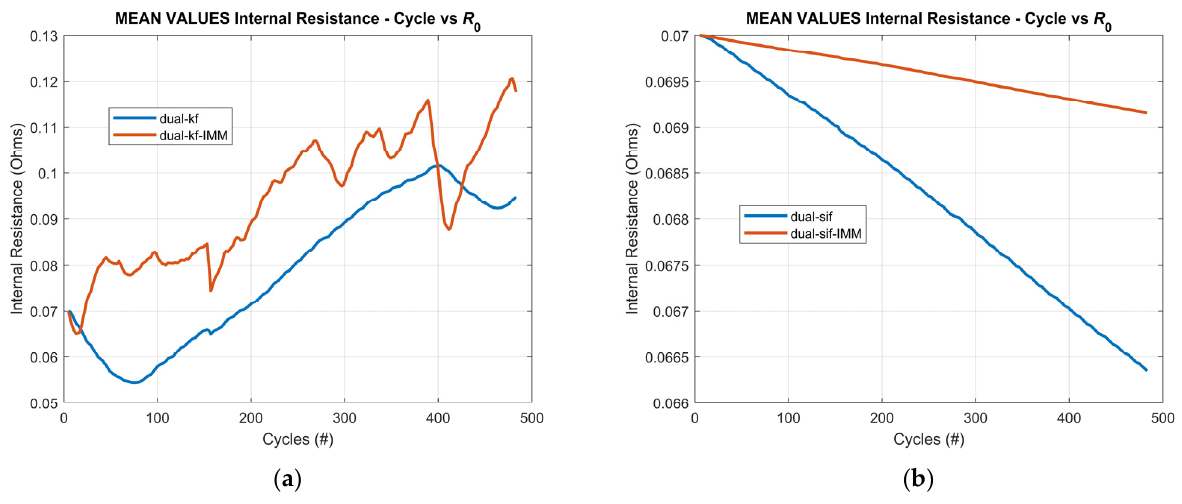
Figure 10. ( a ) Dual-KF and dual-KF-IMM internal resistance estimates. ( b ) Dual-SIF and dual-SIF- IMM internal resistance estimates.